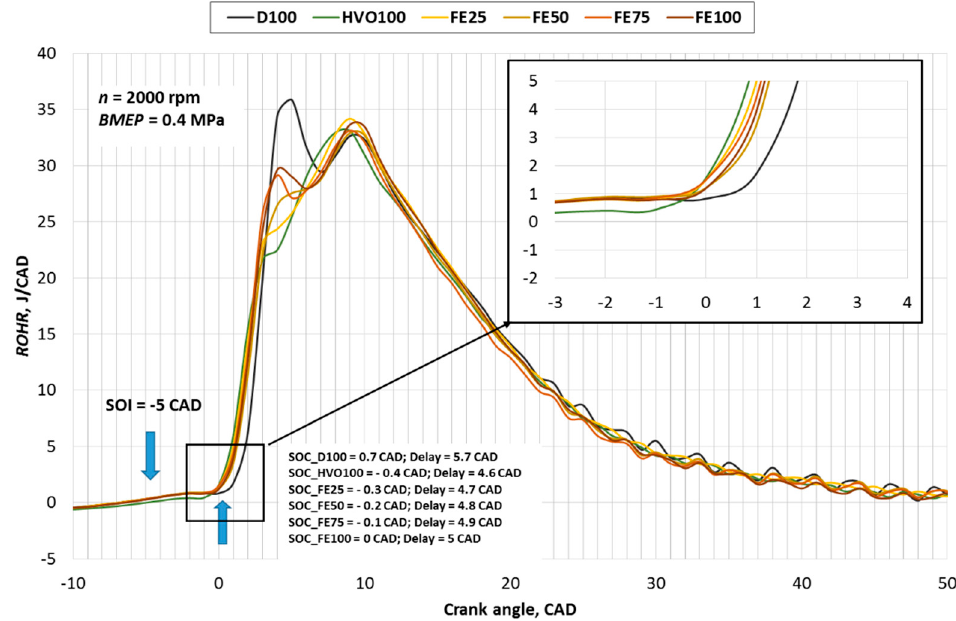
Figure 2. Heat release rate in the cylinder depending on the